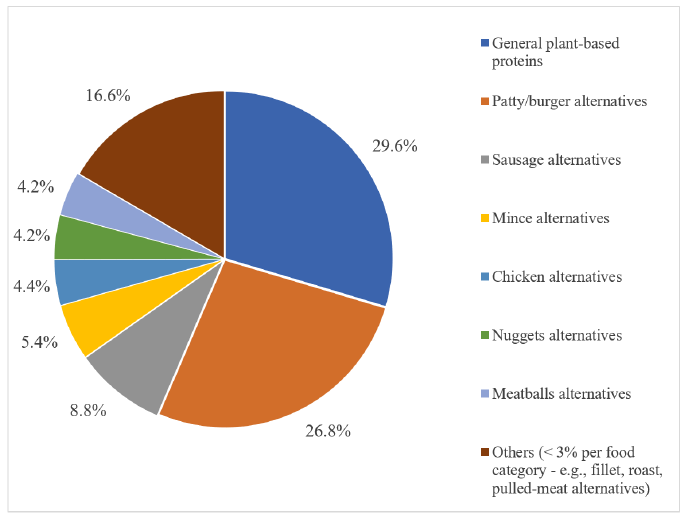
Figure 3. Food category distribution of PBMAs launched over the past three years (2019–2021). Abbreviations: PBMAs, plant-based meat alternatives.